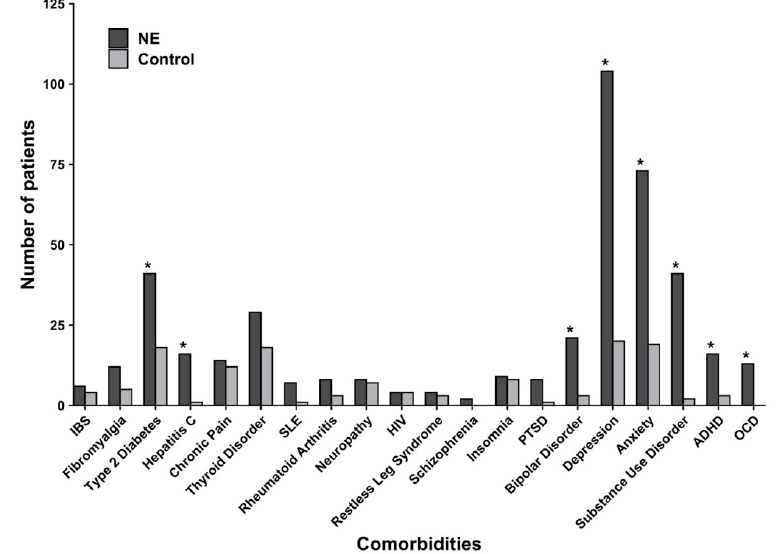
Figure 1. Number of patients with queried comorbidities in the ED and control groups. * Denotes statistically significant di ff erences as determined by a Student’s t -test ( p < 0.05). ED: excoriation disorder; IBS: irritable bowel syndrome; SLE: systemic lupus erythematosus; HIV: human immunodeficiency virus; PTSD: post-traumatic stress disorder, ADHD: attention-deficit / hyperactivity disorder; OCD: obsessive compulsive